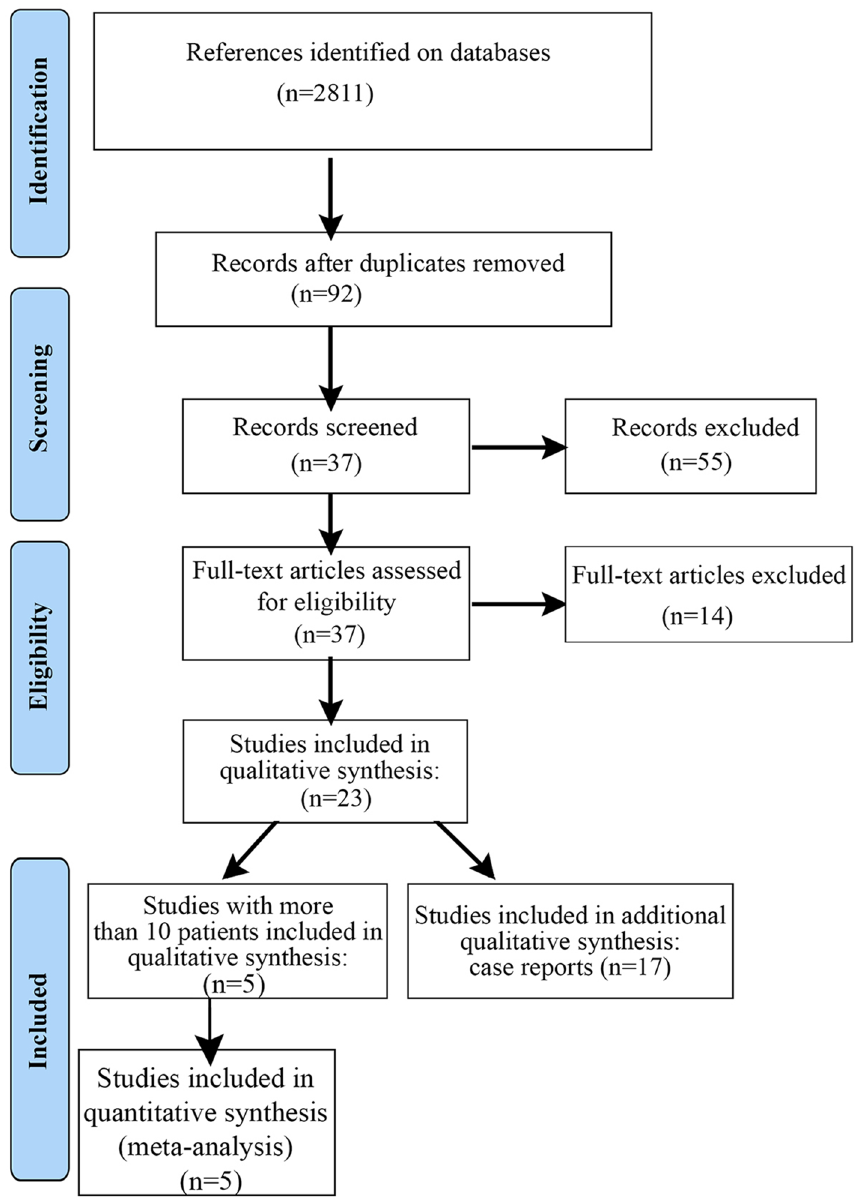
Figure 1. Flow diagram of the literature search strategy and